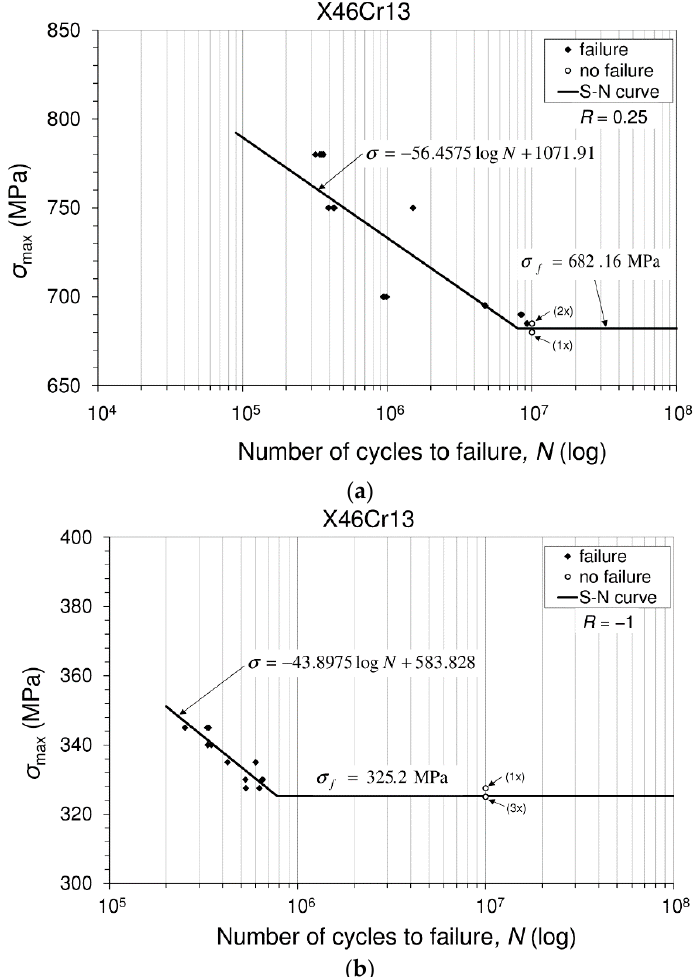
Figure 11. Stress versus number of cycles to failure: experimental data and S–N curve. ( a ) Stress ratio R = 0.25; ( b ) stress ratio R = −